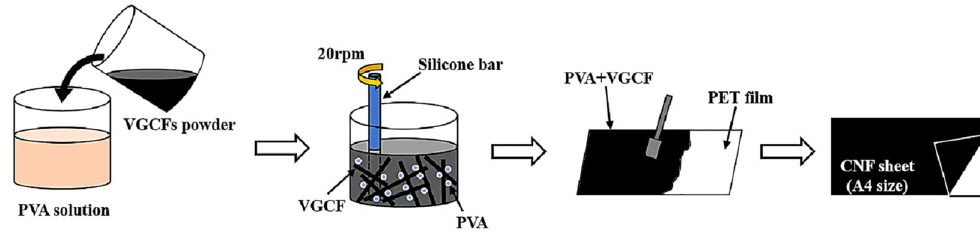
Figure 2. Schematic of the fabrication procedure of CNF